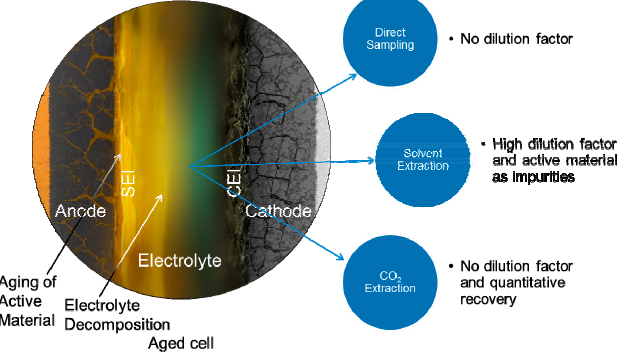
Figure 3. Schematic sketch of an aged lithium ion battery (LIB) and strategies for electrolyte recovery. CEI: cathode electrolyte interphase; SEI: solid electrolyte interphase.